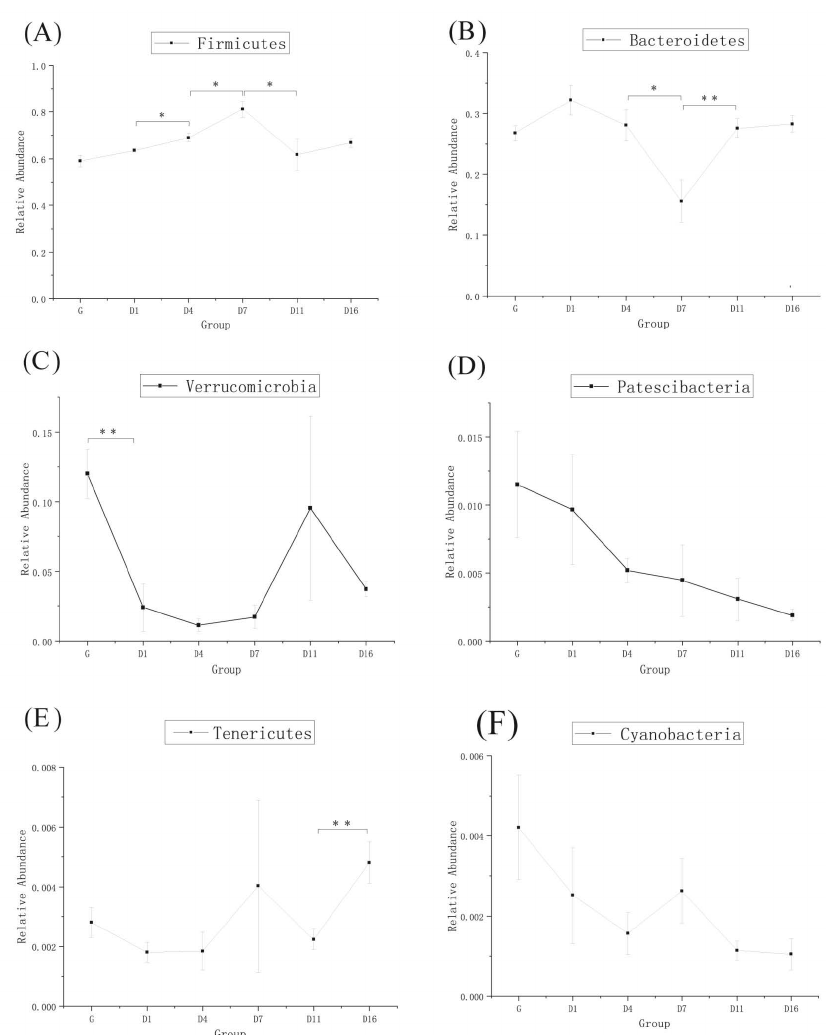
Figure 4. MetaStats analysis of top phylum bacterial of yak, ( A – F ) are the top six phylum, and * means p -value < 0.05, ** means p -value < 0.01. (G: grazing; D1, D4, D7, D11, and D16: feedlot feeding days 1, 4, 7, 11, and 16,